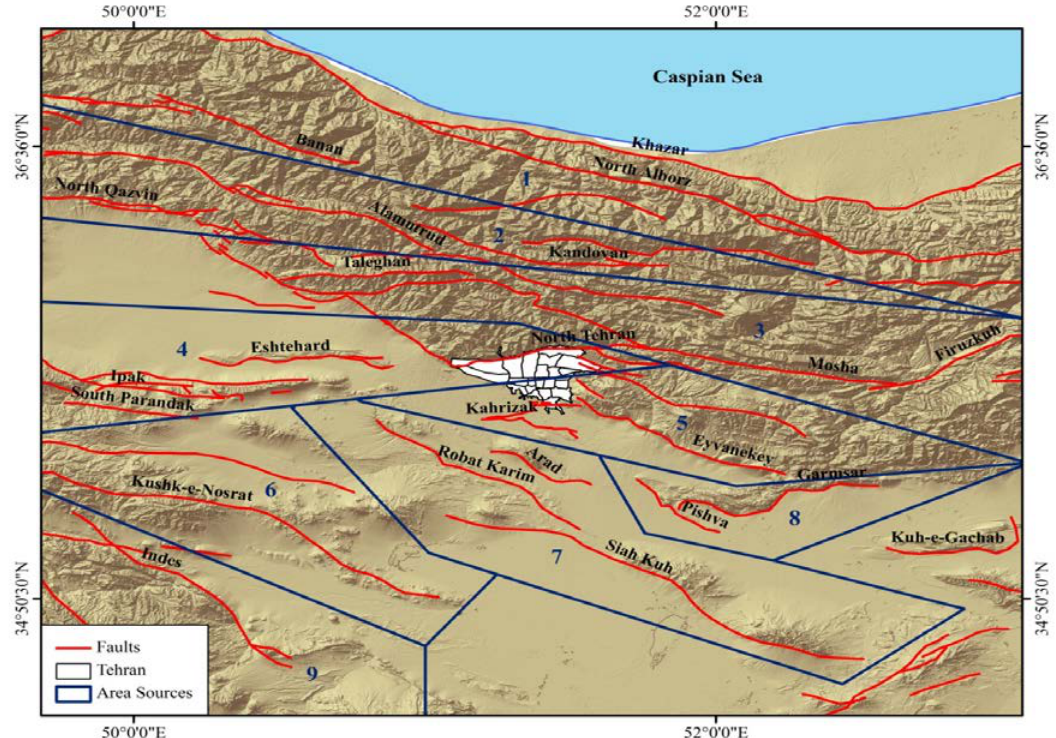
Figure 3. Seismogenic sources of our PSHA analysis for Tehran.